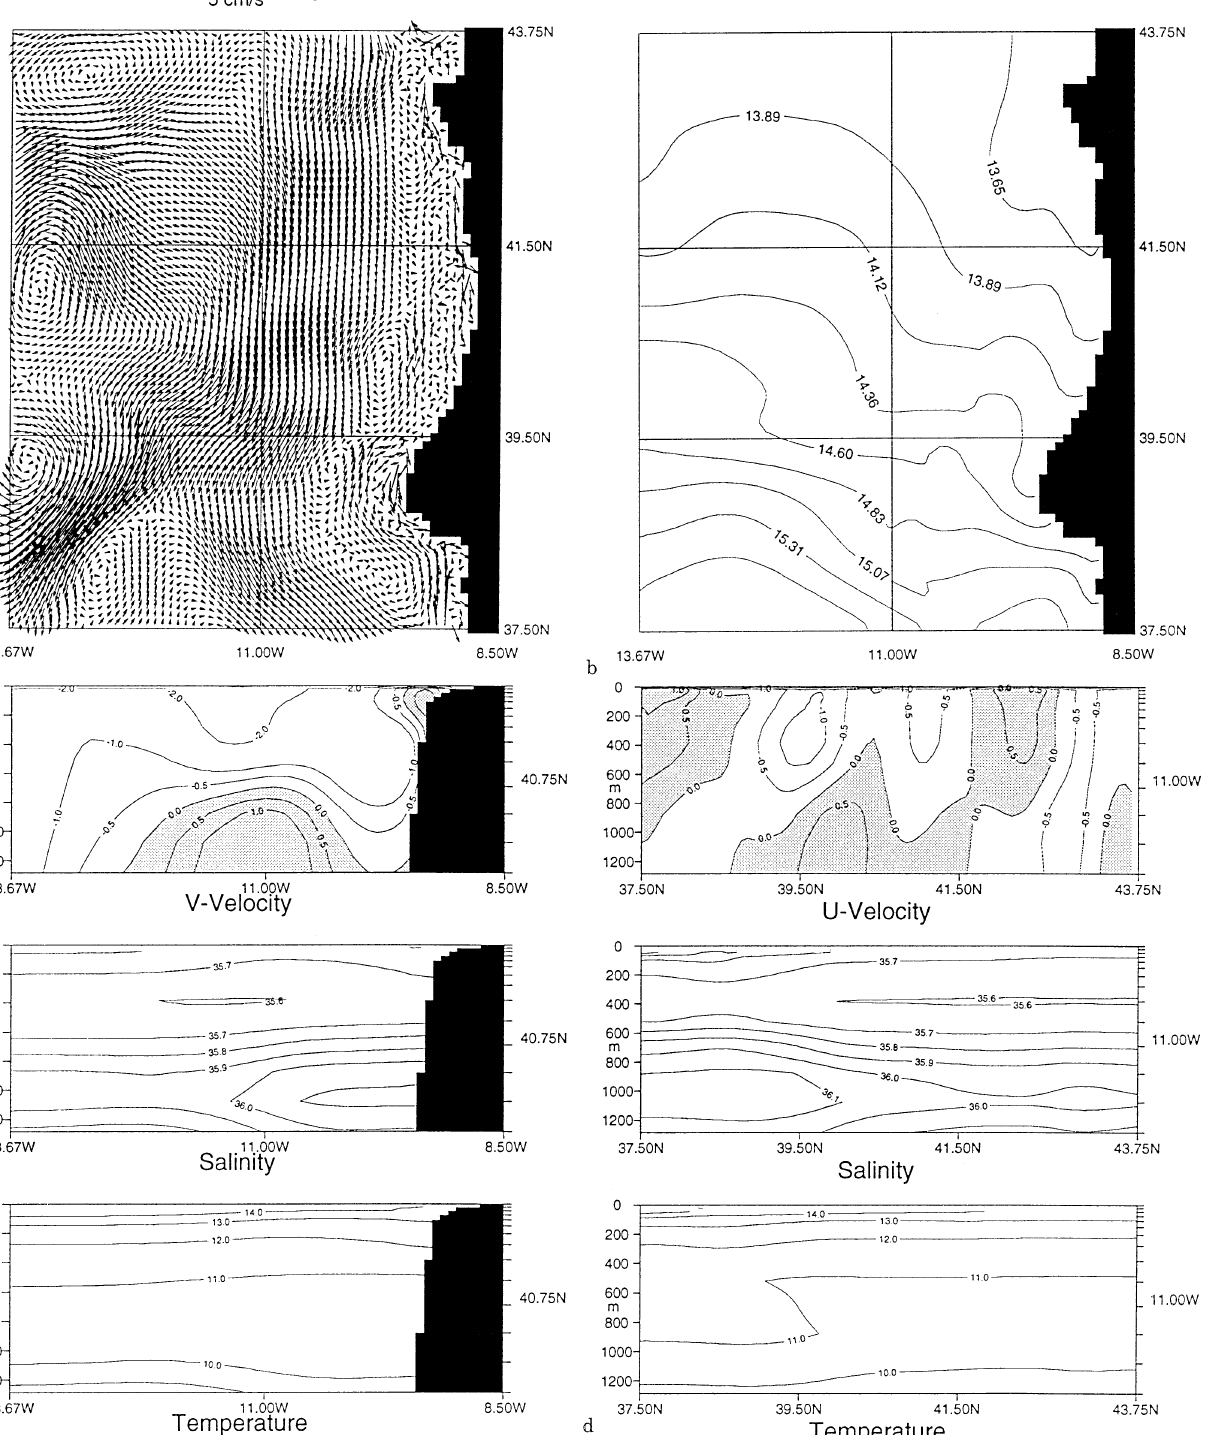
at 40.75 ° N, and d meridional sections of eastwards ( ” ) velocity, salinity and temperature at 11 ° W for case C. Northwards and eastwards velocities in cm s (cid:126)(cid:49)